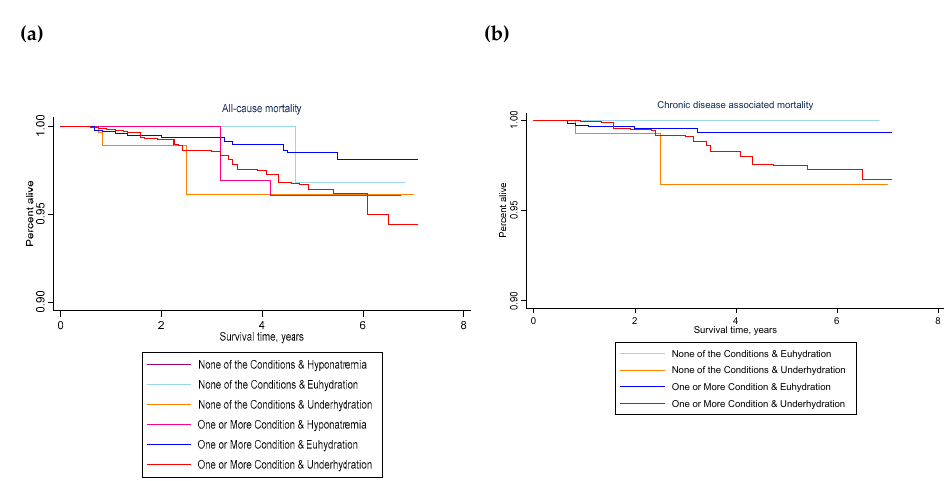
Figure 4. Kaplan–Meier curves for ( a ) all cause and ( b ) chronic disease-associated mortality by chronic